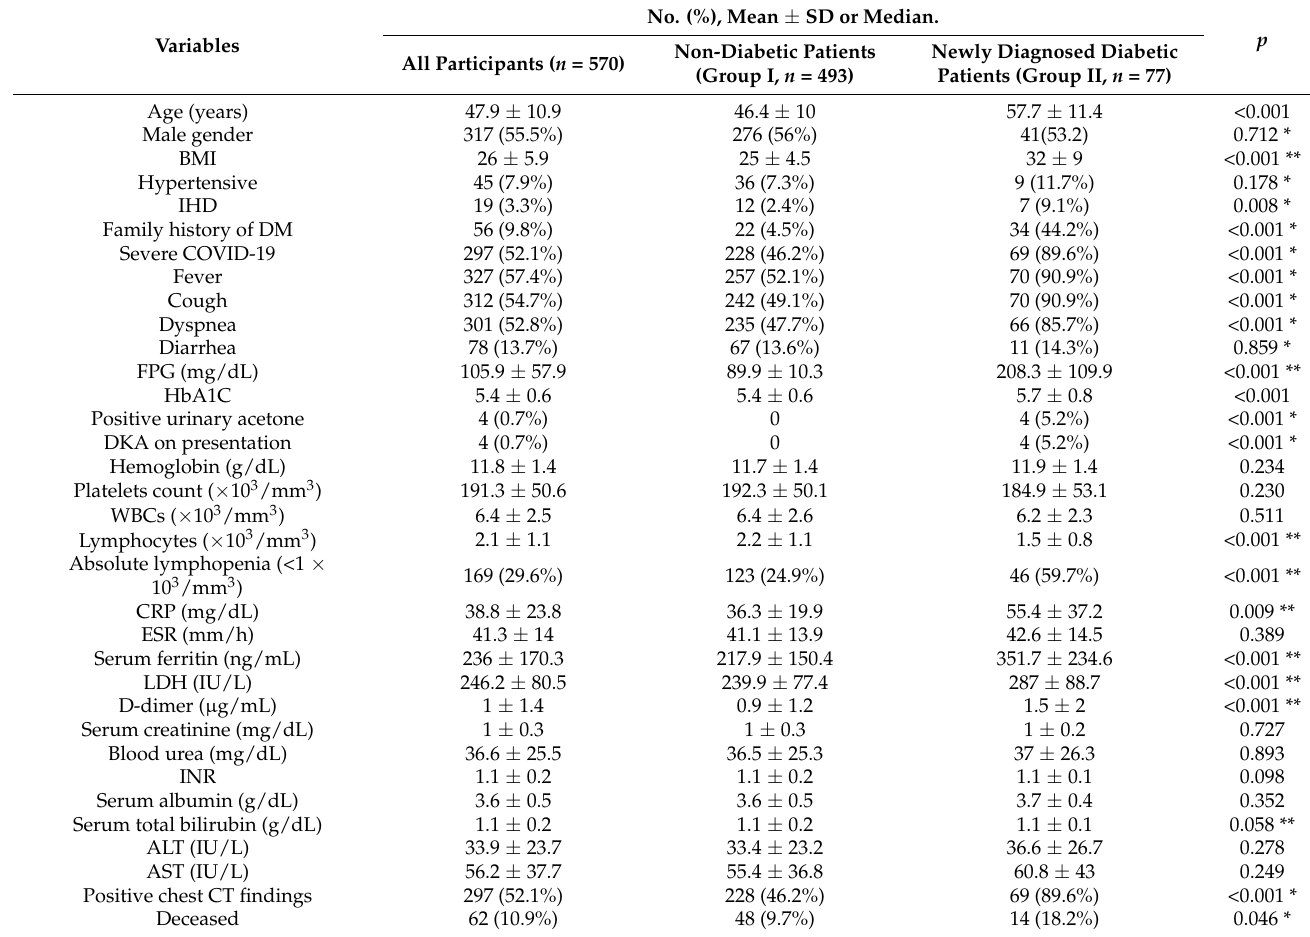
Table 1. Comparison between diabetic and non-diabetic groups regarding clinical, laboratory, and radiological differences. No. (%), Mean ± SD or Median. Variables